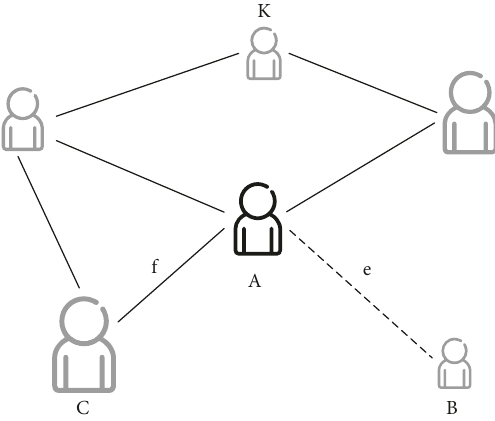
Figure 1: Graphical illustration of in fl uence in a social